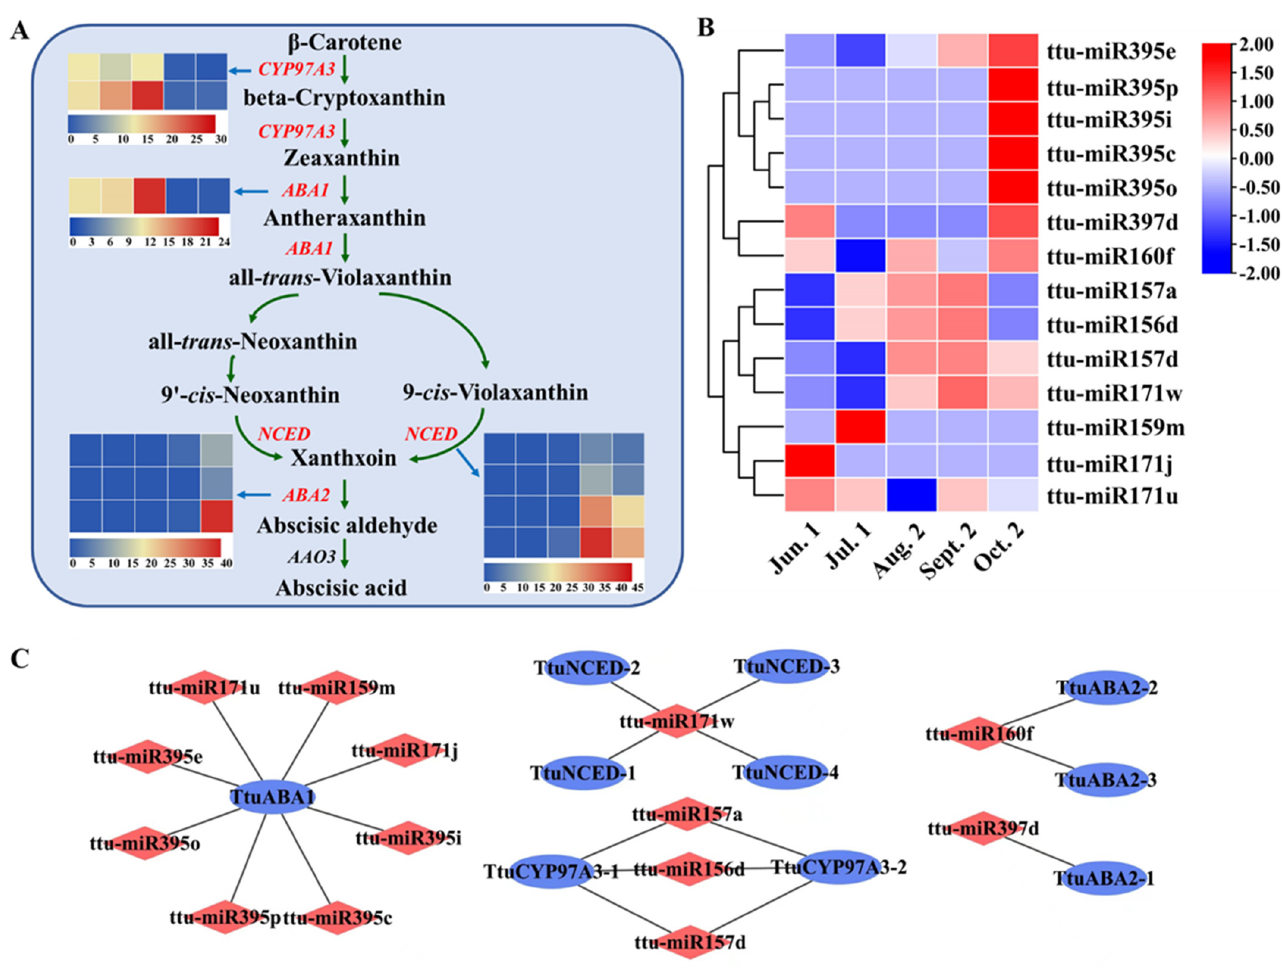
Figure 6. Enrichment analysis of candidate targets in abscisic acid (ABA) pathway. ( A ) Represents miRNA targets functions involved in abscisic acid (ABA) biosynthesis. Heat maps of gene expression levels (FPKM) at five different seed maturation stages. ( B ) Heat map of expressed miRNAs involved in ABA pathway. ( C ) Represents the view of miRNA-mRNA network involved in abscisic acid (ABA) biosynthesis. The red color represents miRNA and the blue color represents targets.